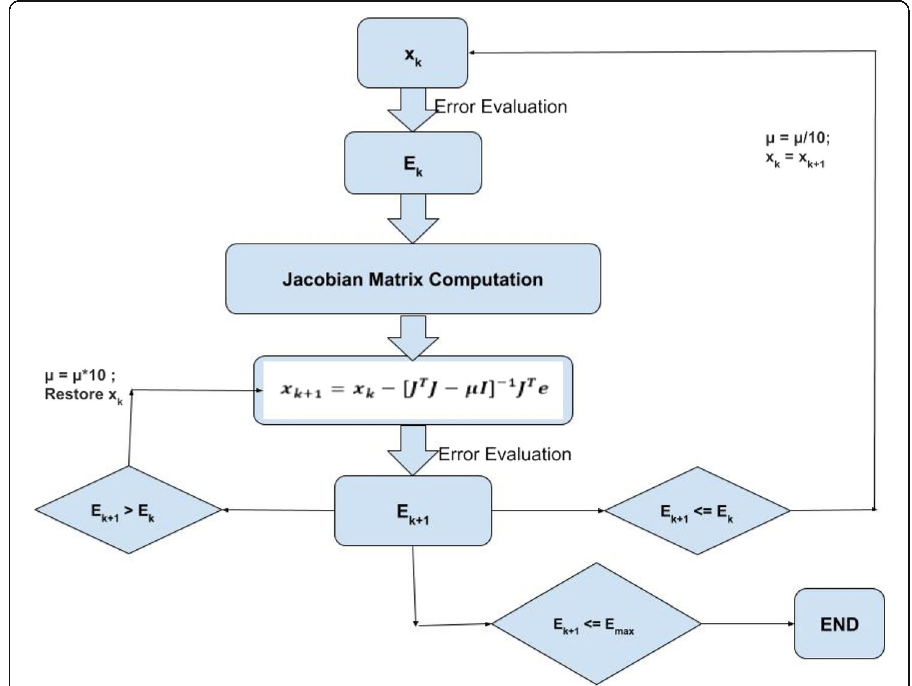
Fig. 2 Flow chart of LM